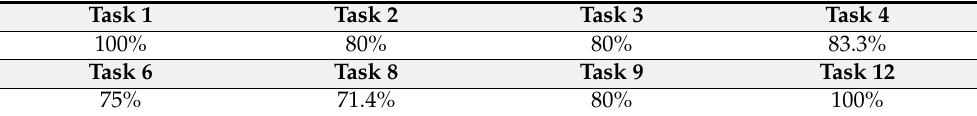
Table 7. Action group coverage.